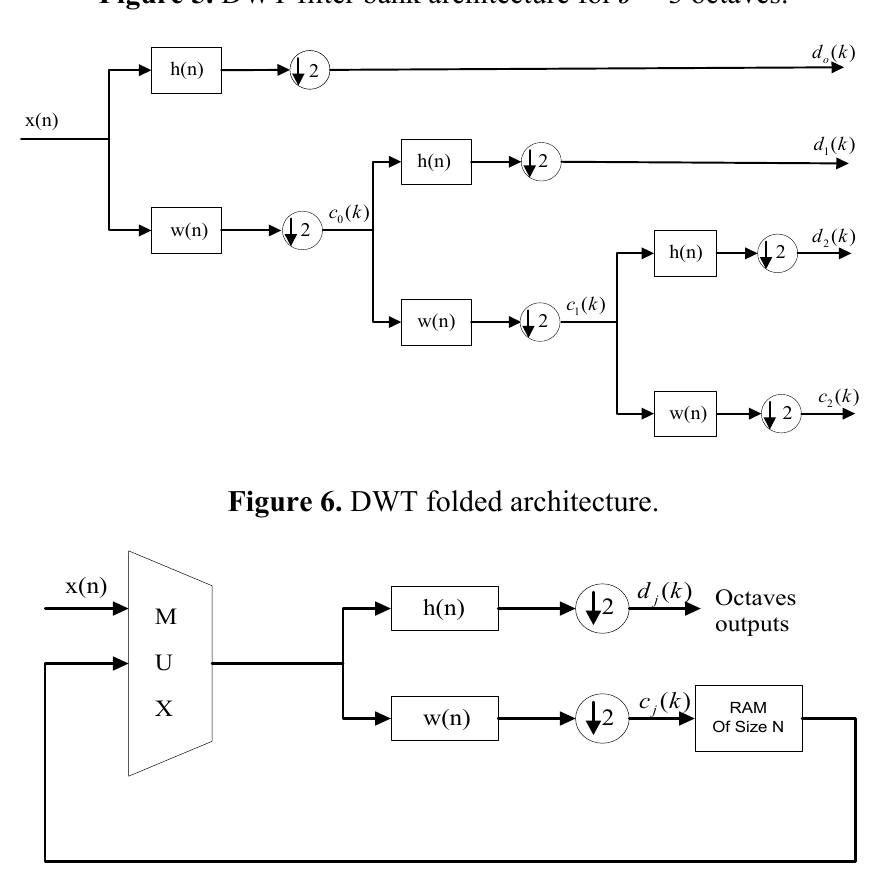
Figure 5. DWT filter bank architecture for J = 3 octaves.